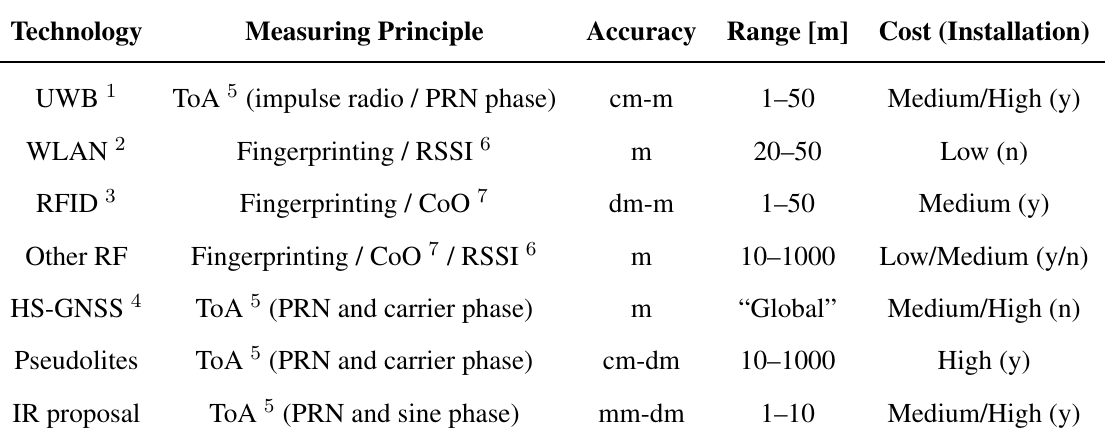
Table 3. Comparison of the IR-based ranging proposal with different RF-based ranging technologies which are typically applied in indoor